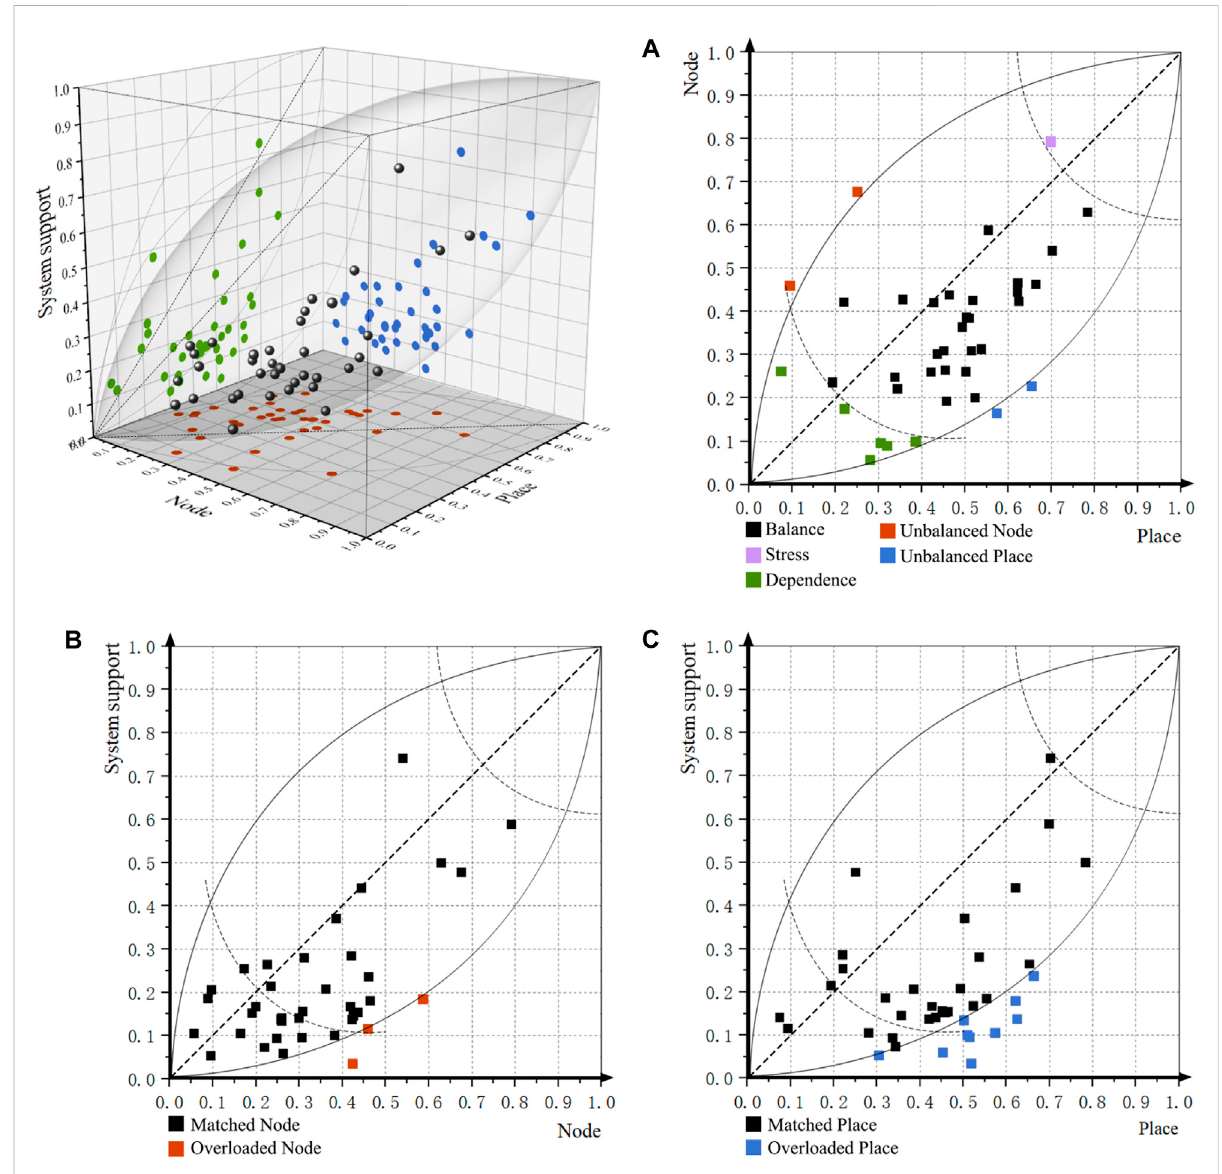
FIGURE 7 Scatterplotofnode,place,andsystemsupportindexesofthemetrostationsintheNPSmodel. (A) Node-placecoordinate (B) Systemsupport- node coordinate (C) System support-place